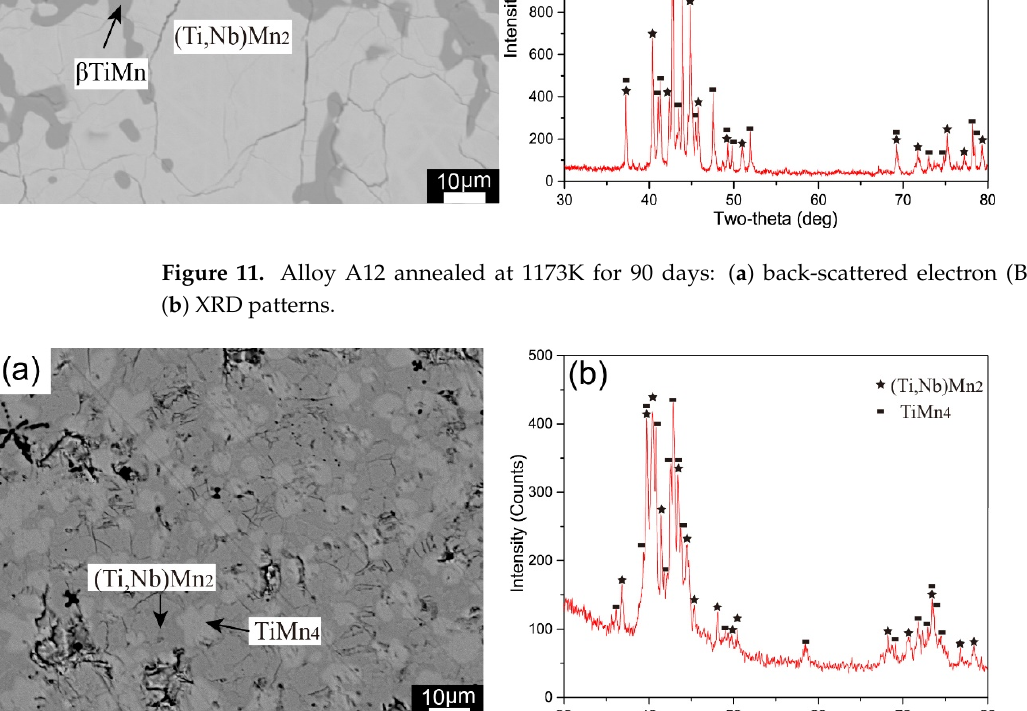
Figure 12. Alloy A16 annealed at 1173K for 90 days: ( a ) back-scattered electron (BSE) images , ( b ) XRD patterns.